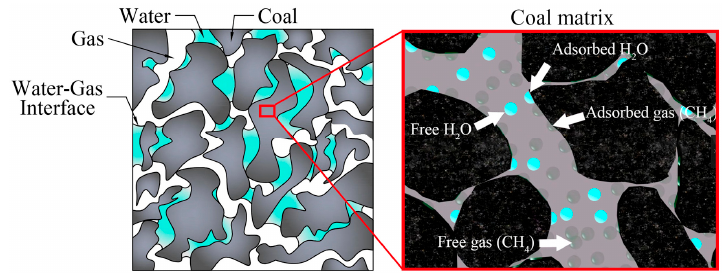
Figure 1. Three-phase structure of coal containing water and gas.